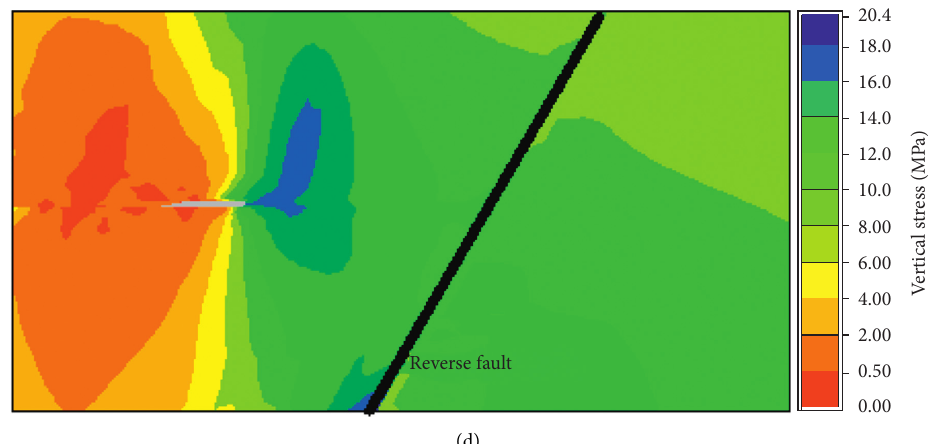
Figure 13: Stress distribution when the distance between working face and reverse fault is 40m with different fault throw. (a) The throw of reverse fault is 4m. (b) The throw of reverse fault is 10 m. (c) The throw of reverse fault is 15m. (d) The throw of reverse fault is